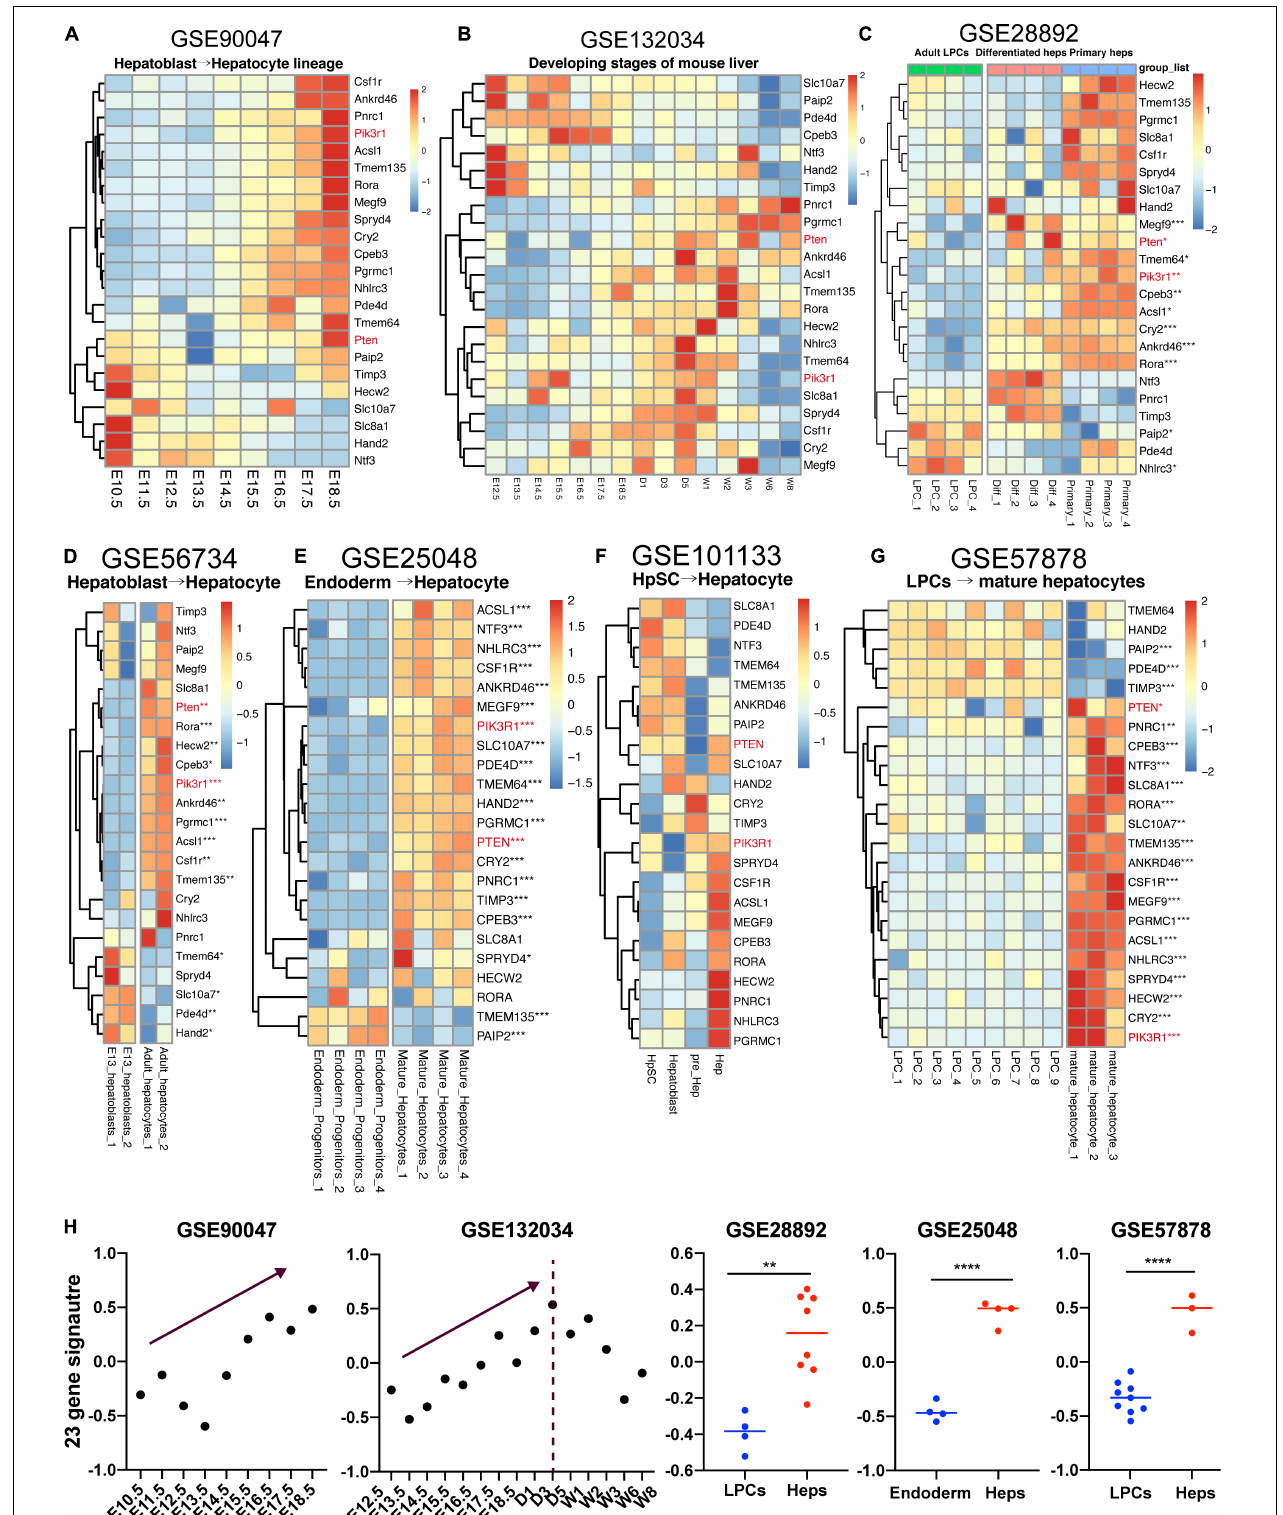
FIGURE 6 | Expression pattern of 23 genes in fetal liver development. (A–G) LPC, liver progenitor cell; Diff, differentiated hepatocyte; Primary, primary hepatocyte; HpSC, hepatic stem cell; Hep, hepatocyte. (H) GSVA analysis of 23-gene signature across the datasets with enough samples. * P < 0.05, ** P < 0.01, *** P < 0.001, and **** P <